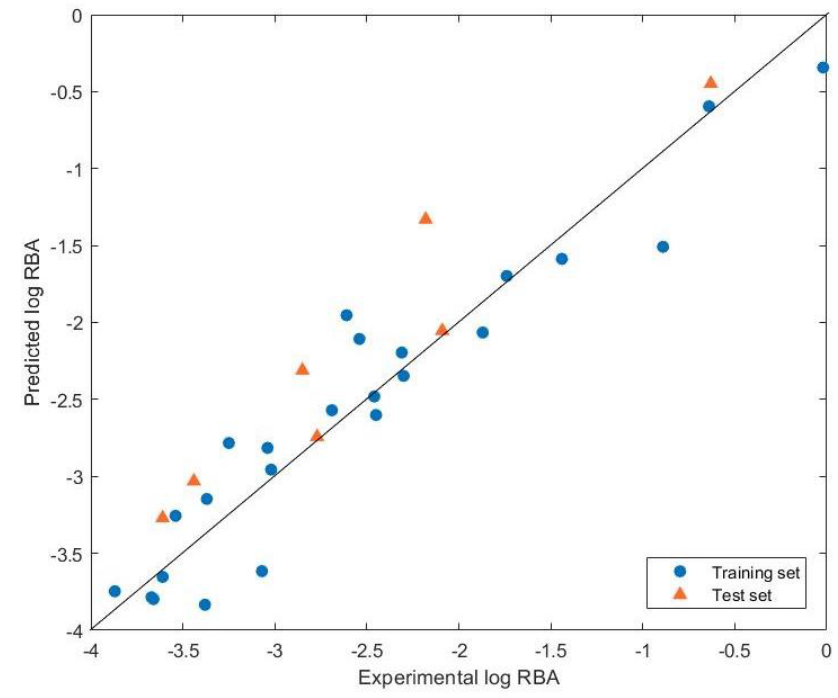
Figure 1. The scatter plot of experimental and quantum chemical GA-MLR predicted log RBA. Table 1. M06-2X/6-31G(d,p)/SCRF calculated descriptors for the quantum chemical GA-MLR Log RBA = 9.8648 ( ± 2.1265) − 2.4609 ( ± 0.2291) LUMO + 73.3633 ( ± 11.1238) µ − − 0.1667 ( ± 0.039) method. Dipole Moment + 0.0067 ( ± 0.0012) APSA